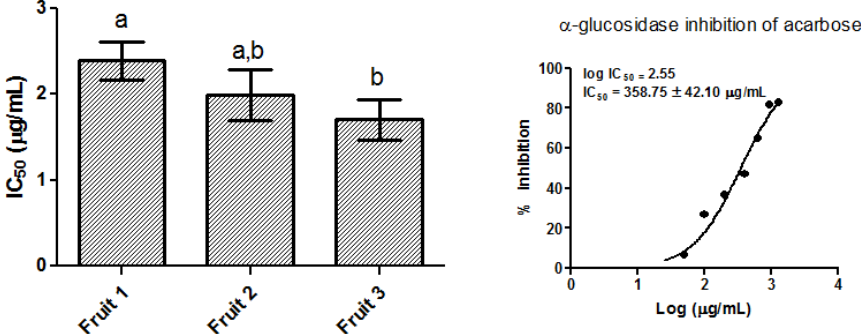
Figure 3. Inhibition of α-glucosidase by baobab fruit pulp extracts and acarbose (standard). Experiments were carried out in triplicate and data were reported as mean ± SD. Significant differences ( p < 0.05) are highlighted with different letters (a, a,b and b).